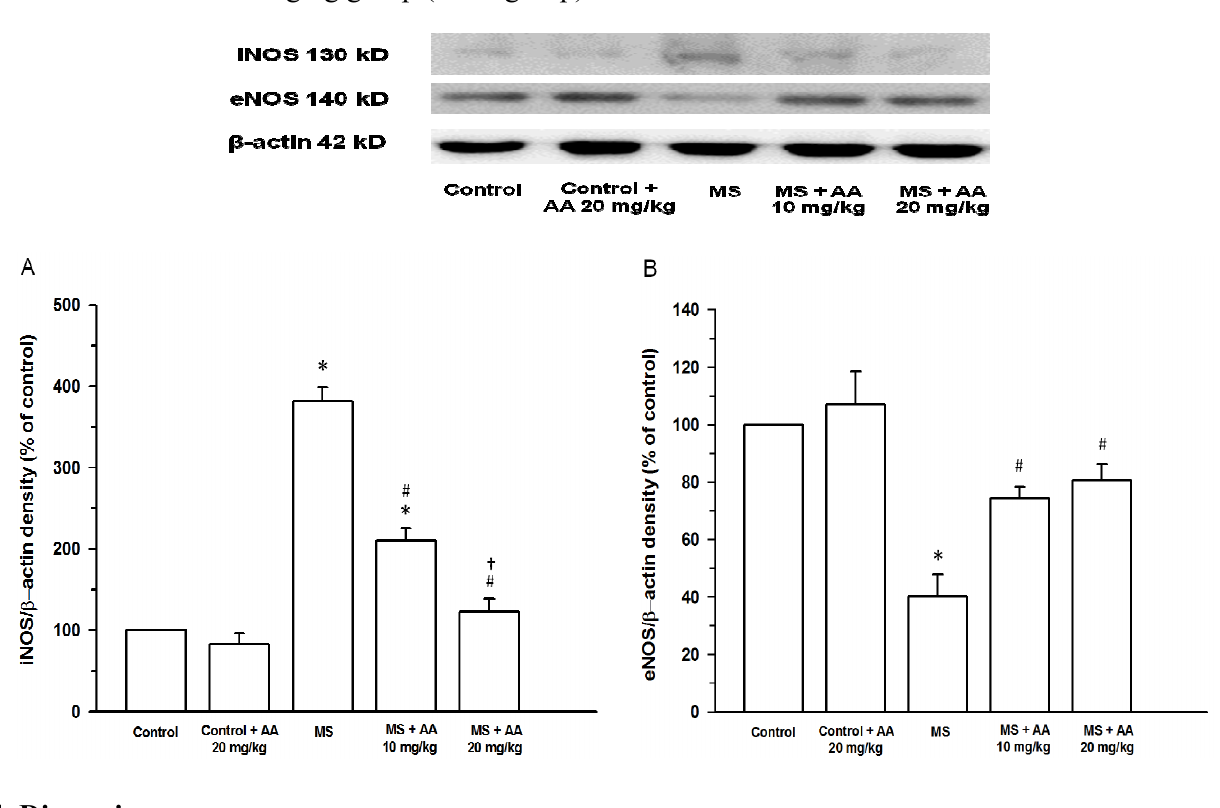
Figure 6. Effect of asiatic acid on iNOS protein expression ( A ) and eNOS protein expression ( B ) in all experimental groups. Results are expressed as mean ± SEM. AA represents asiatic acid. * p < 0.05 vs . control group, # p < 0.05 vs . MS group, † p < 0.05 vs . MS + AA 10 mg/kg group ( n =